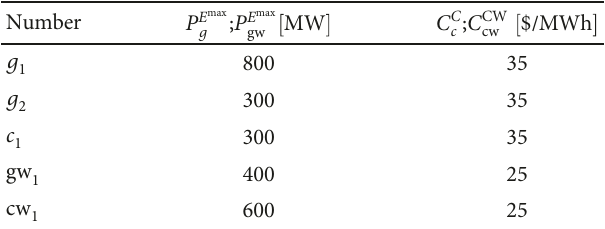
Table 18: Data for existing and candidate generators.